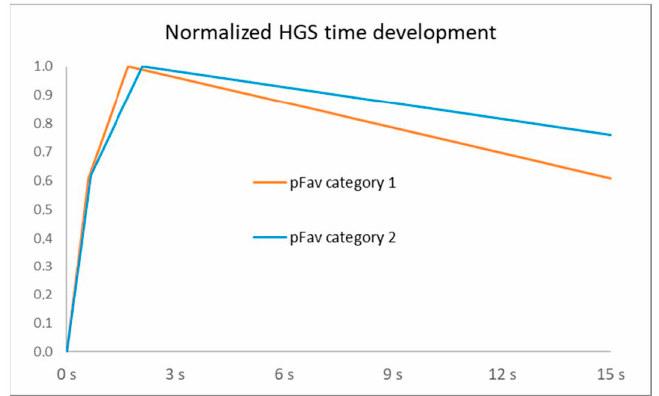
Figure 4. Sketch of HGS vs. time for the two groups of participants.